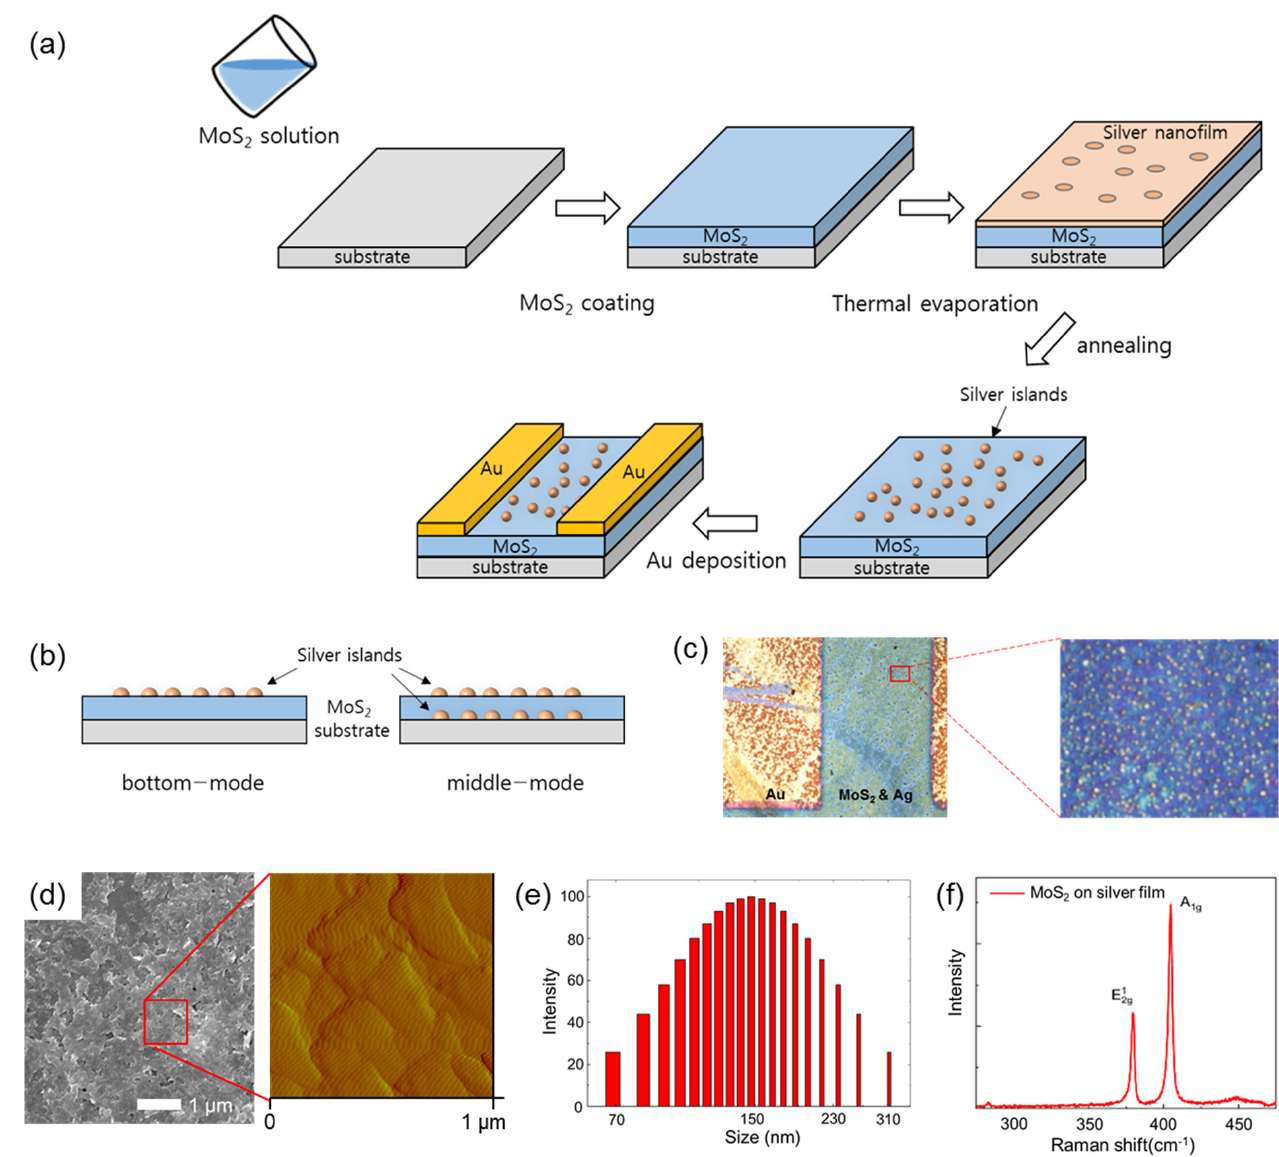
Figure 1. ( a ) Illustration of the fabrication of photodetecting devices. ( b ) Schematic of the bottom- and middle-mode structures. ( c ) Optical image of the fabricated device and magnified image of Ag islands on the MoS 2 layer. ( d ) SEM image of MoS 2 film and magnified AFM image of boxed area ( e ) Size distribution of the MoS 2 NFs. ( f ) Raman spectra of MoS 2 film on silver film.